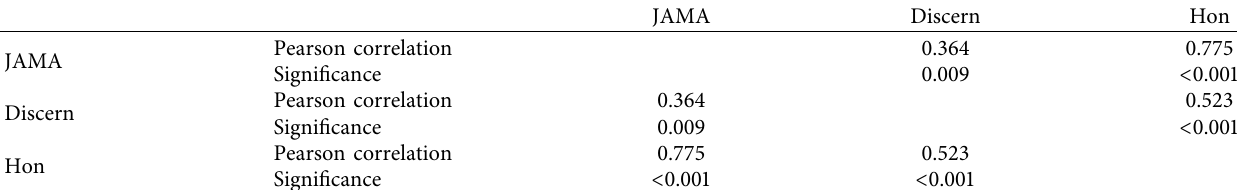
Table 2: Correlation between scores measuring video quality (Pearson’s